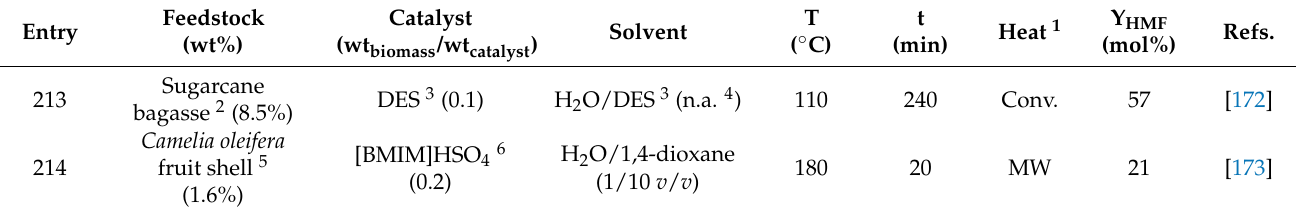
Table 11. HMF production starting from raw pretreated biomasses in biphasic and/or multiple- solvent systems with ionic liquid and deep eutectic solvent as